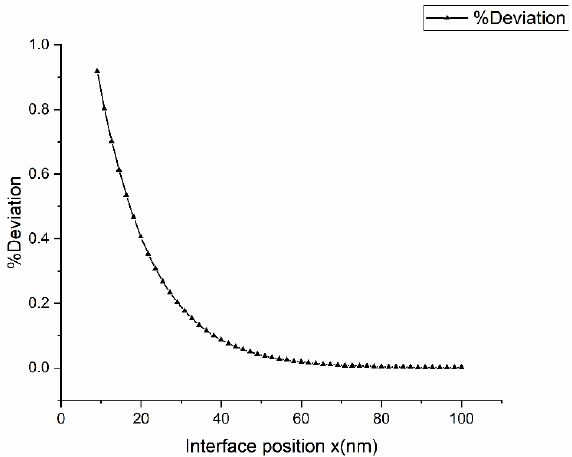
Figure 6. Variation of solid composition along with the interface.